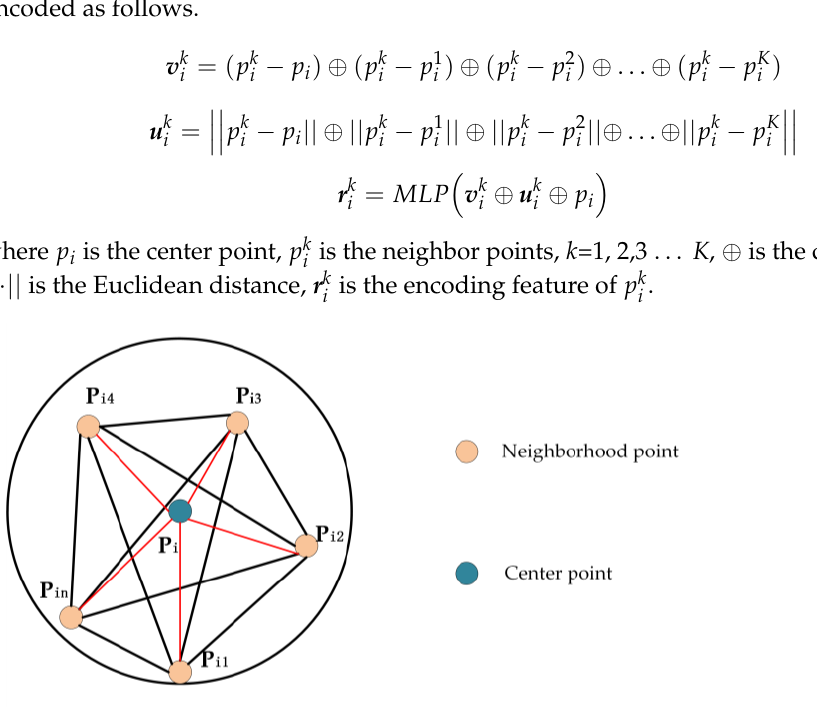
Figure 3. The local fully connected graph. P i is the center point, P i 1 , P i 2 . . . P in is the points within the the neighborhood.